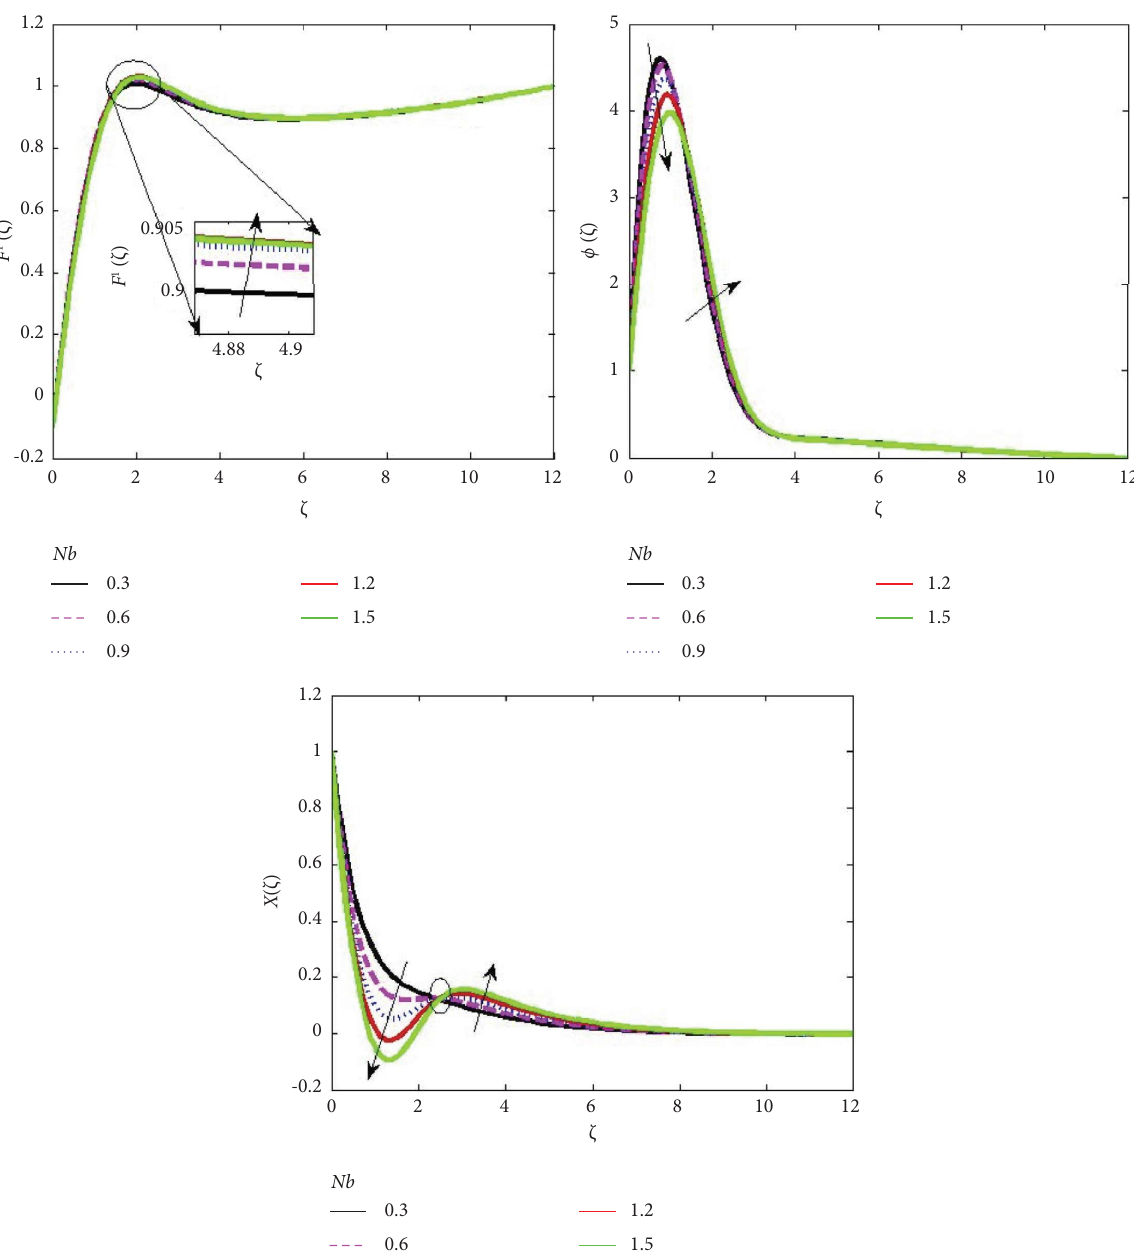
Figure 10: Efect of the Brownian motion parameter on the velocity, concentration, and motile density